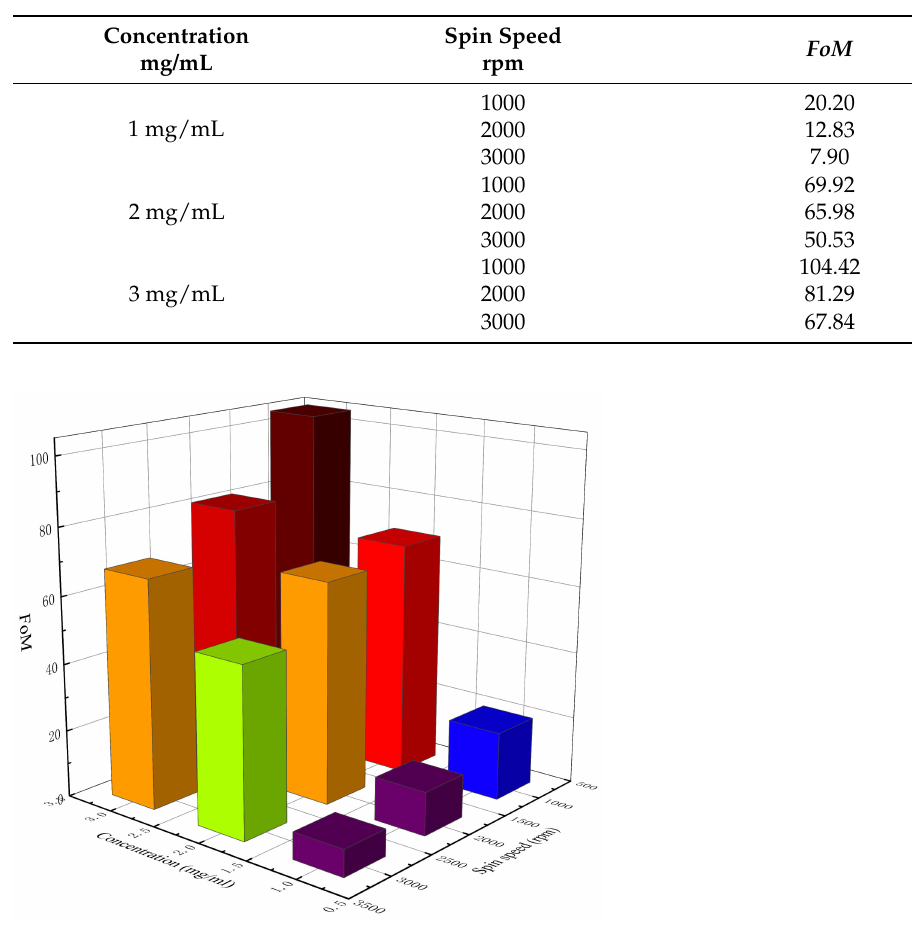
Table 4. The FoM of the AgNW transparent electrode at different concentrations and spin speeds.